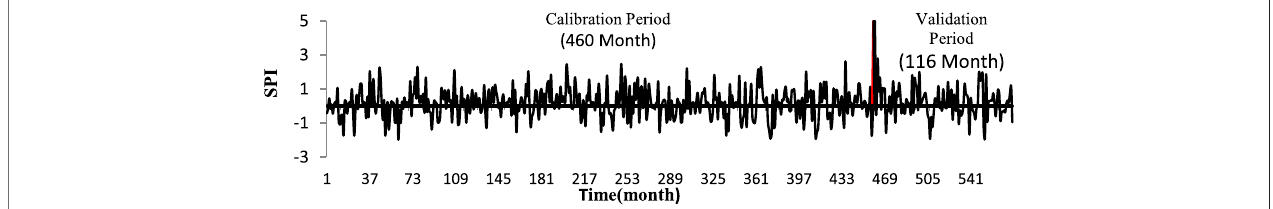
FIGURE 2 | Time series of one-month SPI drought index in